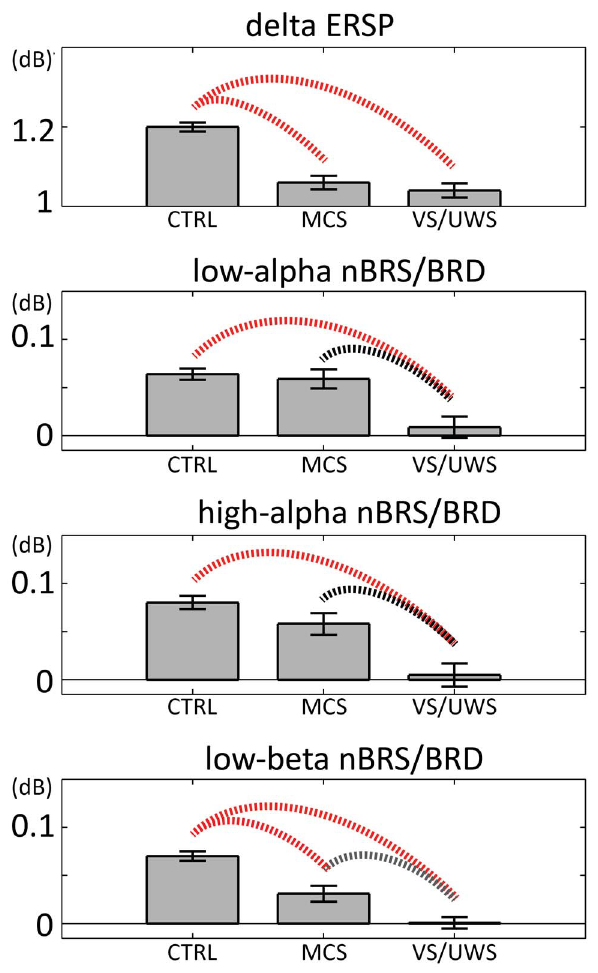
Figure 4. Descriptive statistics of group normalized power and significant between-groups post-hocs. For each band, descriptive statistics (mean 6 standard error) of groups normalized power (ERSP for delta and nBRS/BRD for low-alpha, high-alpha and low-beta) and significant between-groups post-hocs are depicted. In each plot the first bar refers to CTRL, the second to MCS and the third to VS/UWS. Only p-values of significant (at least , 0.05) post-hocs are highlighted. Red arcs correspond to p , 0.001, black arcs to p , 0.01 and grey arcs to p , 0.05. Regarding delta ERSP, significantly higher levels were found for CTRL both when compared with MCS and VS/UWS. For the other three bands, a significant difference was found both between CTRL and VS/ UWS, and between MCS and